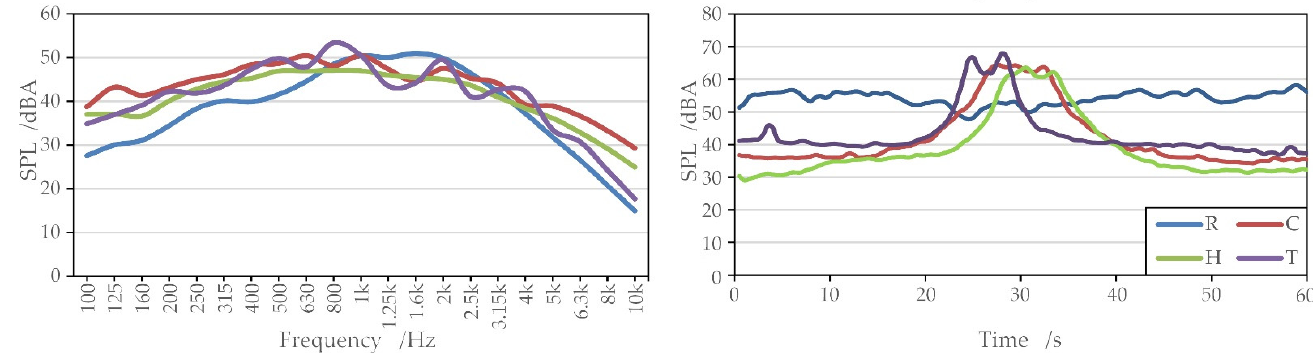
Figure 3. Spectral and temporal characteristics of four traffic noises, including road traffic (R), conventional train (C), high-speed train (H), and tram (T).